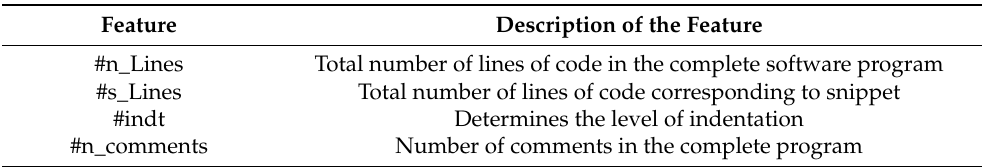
Table 2. Table representing the static features associated with the software.